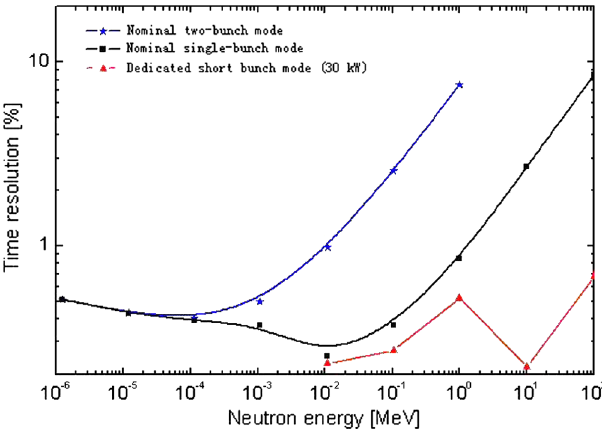
FIG. 8. The rms extraction bunch length with different injection voltages in mode B.